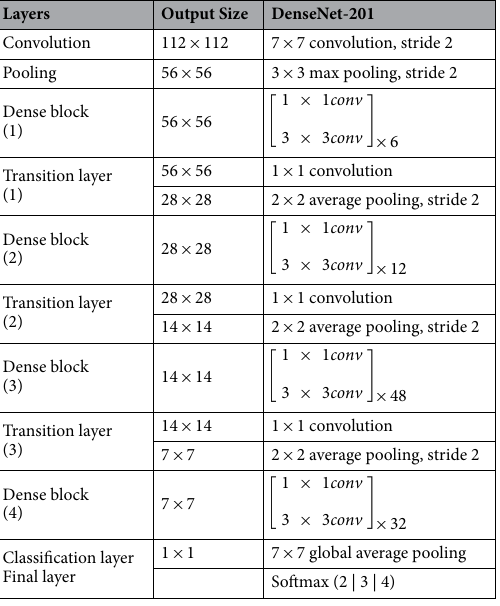
Table 6. DenseNet-201 architecture details for the experiments. In the final layer, 2 refers to the malignant and benign classes; 3 refers to the malignant, dysplasia, and benign classes; and 4 refers to the malignant, dysplasia, uncategorized, and benign